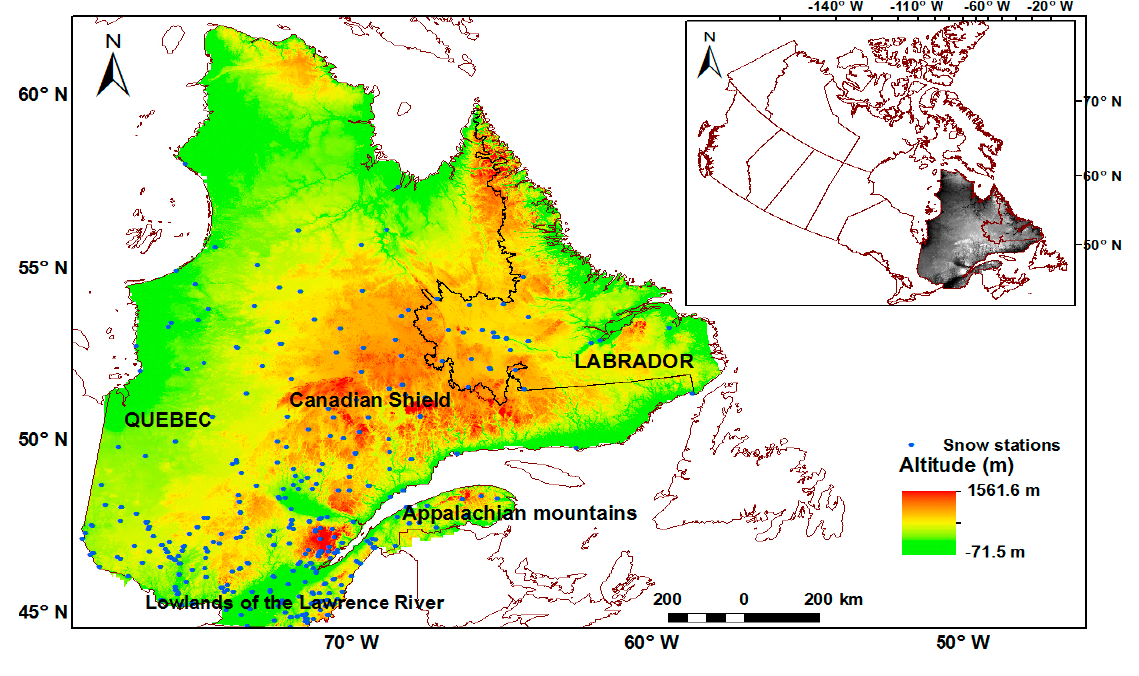
Figure 1. The studied territory.